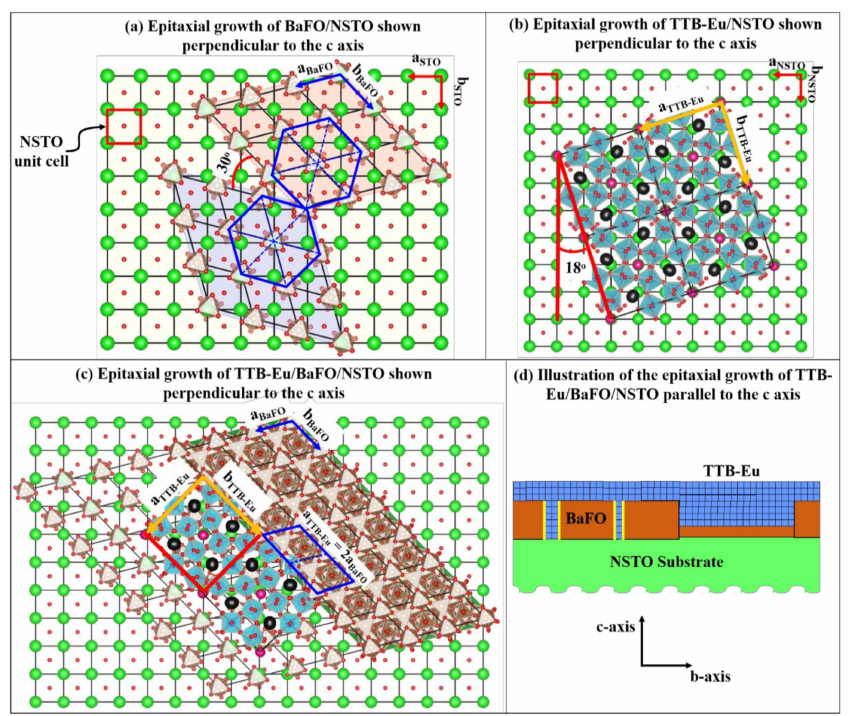
Figure 3. Crystallographic model illustrating the epitaxial relationships: ( a ) illustration of the epitaxial growth of the BaFO on the NSTO structure, where the two different in-plane orientations of the BaFO unit cells with respect to the NSTO crystal structure are shown, azimuthally separated by 30 ◦ . ( b ) Illustration of the epitaxial growth of the TTB-Eu directly on NSTO substrate, showing an in-plane rotation of 18 ◦ of the TTB-Eu unit cell with respect to the substrate lattice. This in-plane orientation corresponds to the eight peaks with low intensity observed in the red diffractogram in the Figure 2b. ( c ) Illustration of the epitaxial growth of TTB-Eu on top of an epitaxial BaFO/NSTO heterostructure. ( d ) Cross-sectional sketch shown along the [100] direction of NSTO illustrating the different variants of epitaxial growth of the TTB-Eu/BaFO/NSTO, with TTB-Eu growing both on top of BaFO or directly on top of NSTO, or possibly also on top a very thin BaFO layer, thin enough for the epitaxy to be determined using the underlying substrate crystal structure. The yellow lines illustrate the presence of a lateral epitaxial matching along the c-axis between the c BaFO and stack of 6 × c TTB-Eu , implying an additional coupling between the TTB-Eu and BaFO which is benefic for the magnetoelectric